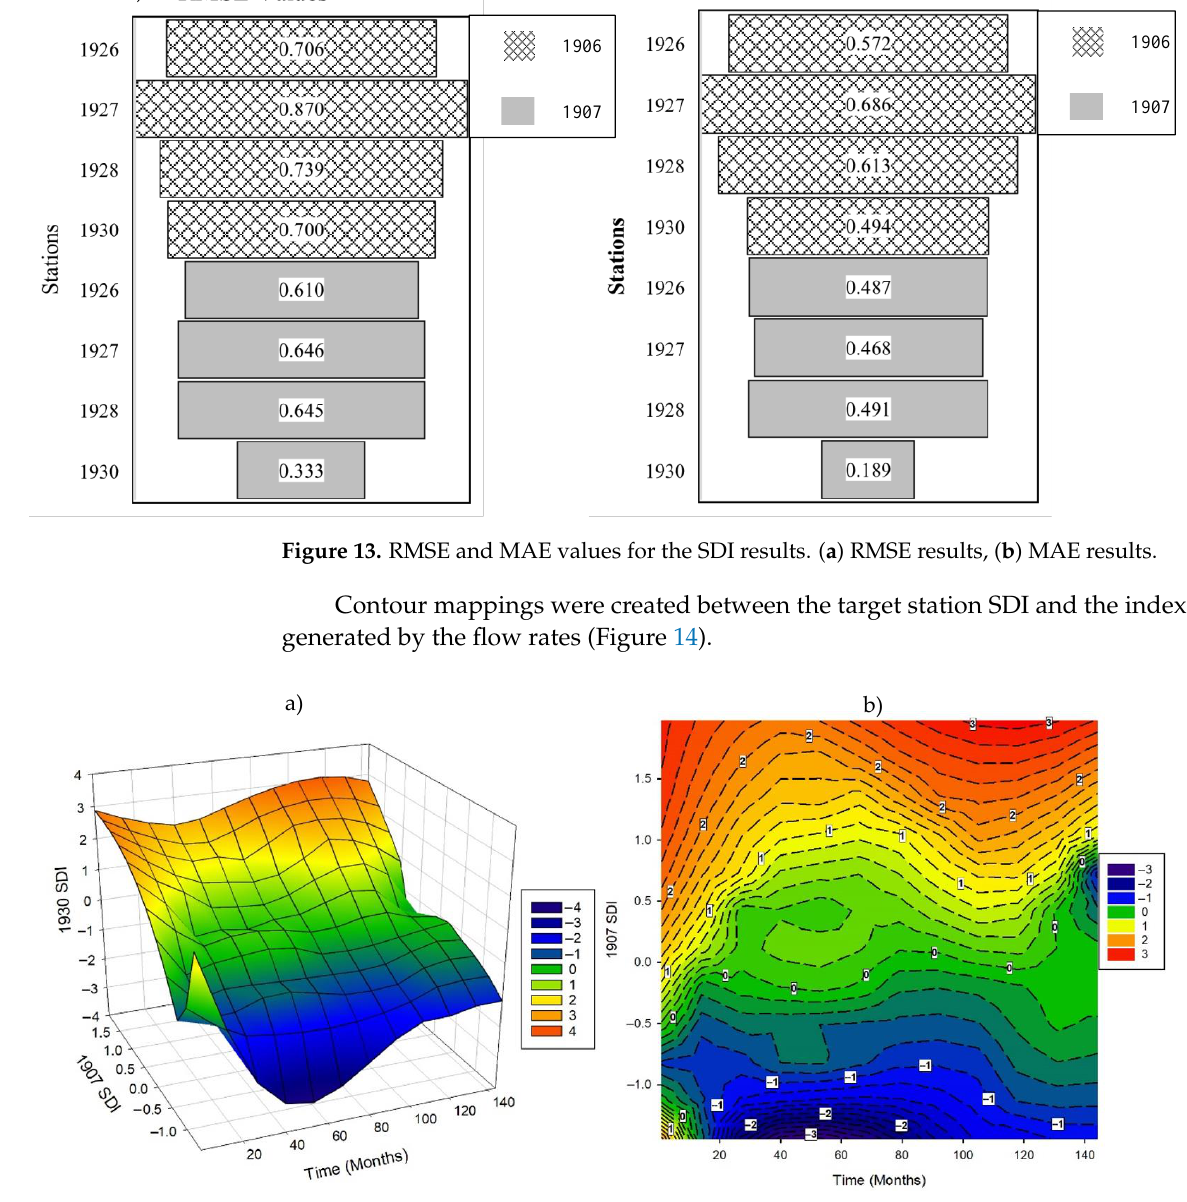
Figure 14. Contour maps for the 1907 SGS raw data, the SDI results with the original values and the SDI values with the transferred flow data. ( a ) 1907 and 1930 3D Mesh graph over time, ( b ) 1907 and 1930 contour graph over time.